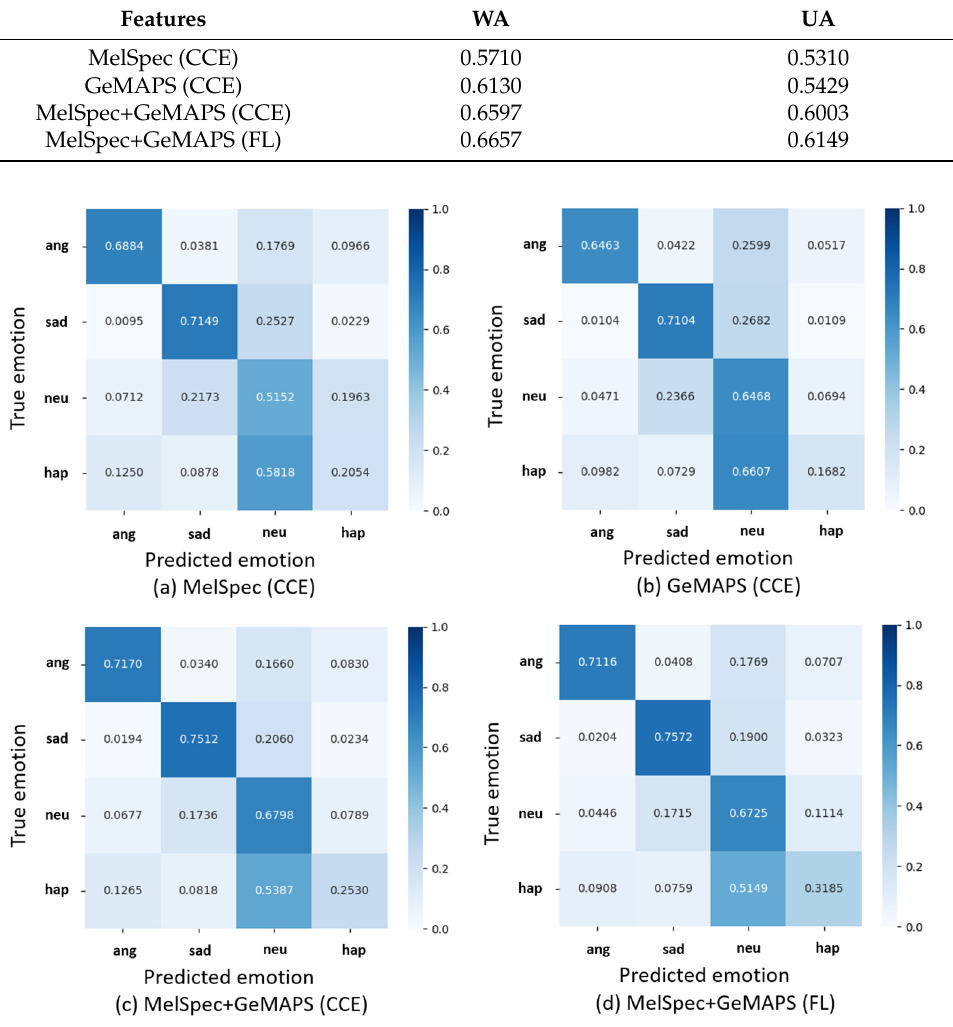
Figure 2. Confusion matrixes obtained in four experimental